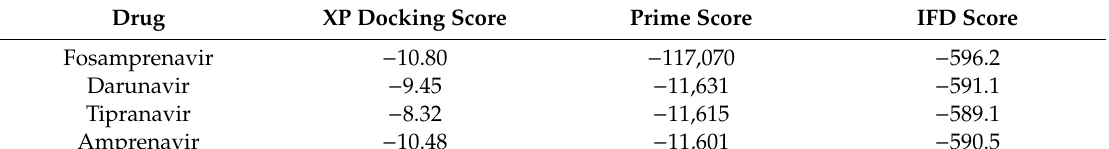
Table 4. IFD results of the best-scored HIV antiviral molecules.